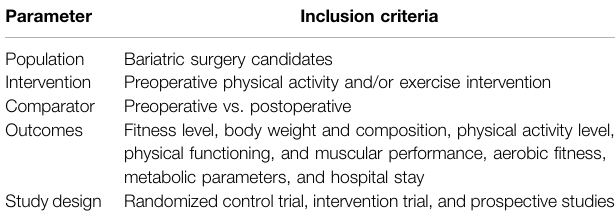
TABLE 1 | PICOS criteria for inclusion of studies. Parameter Inclusion criteria Population Bariatric surgery candidates Intervention Preoperative physical activity and/or exercise intervention Comparator Preoperative vs. postoperative Outcomes